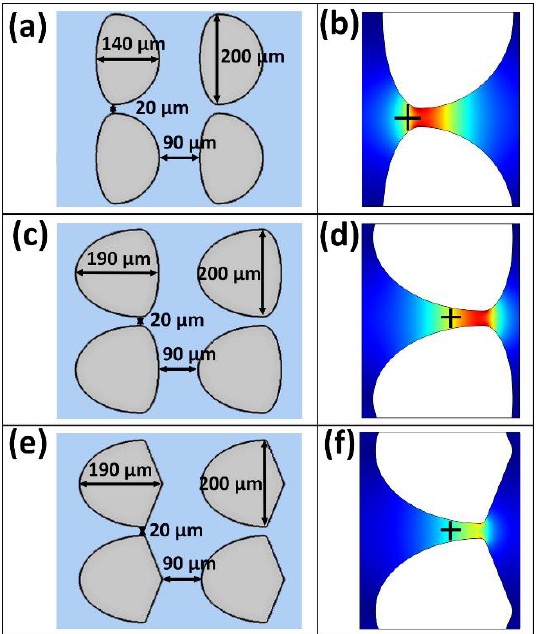
Figure 5. Schematic representation of the post dimensions and close-up of a constriction depicting the E distribution for three distinct post shapes: ( a , b ) oval–narrow–oval posts, ( c , d ) oval–wide–oval posts and ( e , f ) oval–wide–diamond posts. The color distribution represents the magnitude of E where red represents the highest E magnitude, and the black crosses represent the location at which the sTV values were estimated.